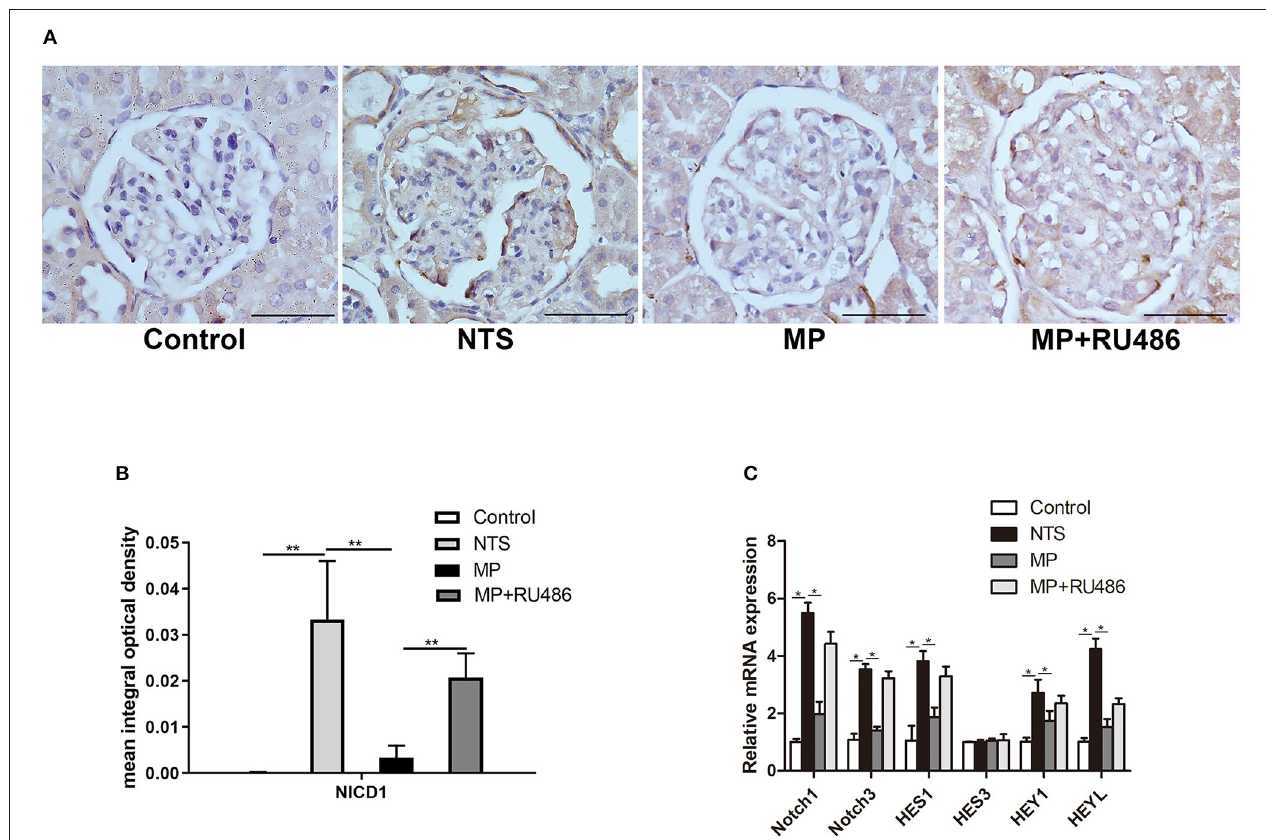
FIGURE 5 | Glucocorticoids prevented Notch signaling activation in podocytes of NTS-treated rats. (A) Immunohistochemistry staining of NICD1 in sections of kidney biopsies from rats treated with saline (control), NTS, NTS + MP, and NTS + MP + RU486, respectively ( n = 5 per group). Quantification of immunostaining intensity for NICD1 in glomerular tuft is shown in (B) ; (C) The relative mRNA expression of Notch pathway genes (Notch1, Notch3, Hes1, Hes3, Hey1, and HeyL) from isolated glomeruli of the rats treated as indicated on day 14 ( n = 5 per group). * P < 0.05, ** P < 0.01. Scale bars, 50 µ